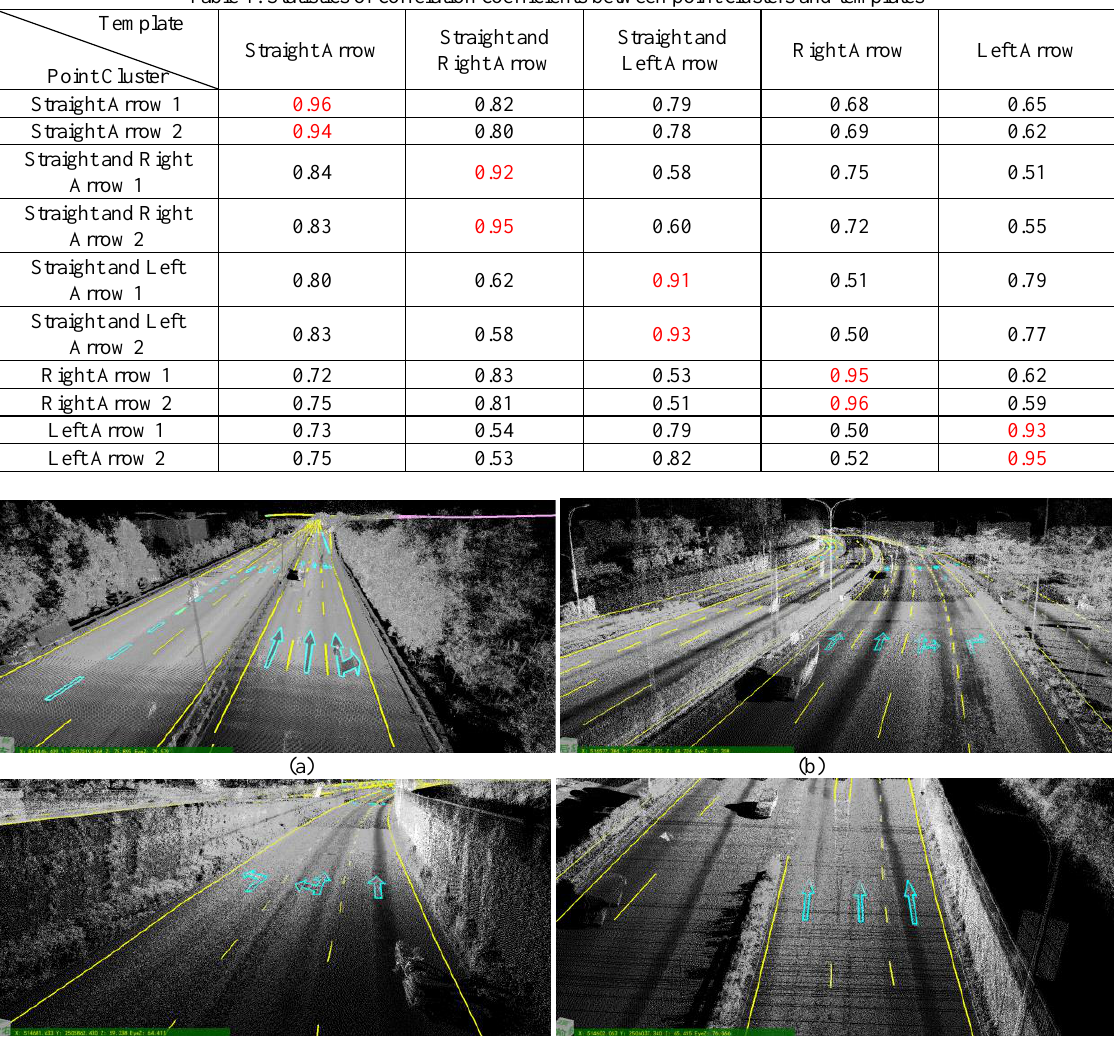
Table 1. Statistics of correlation coefficients between point clusters and templates